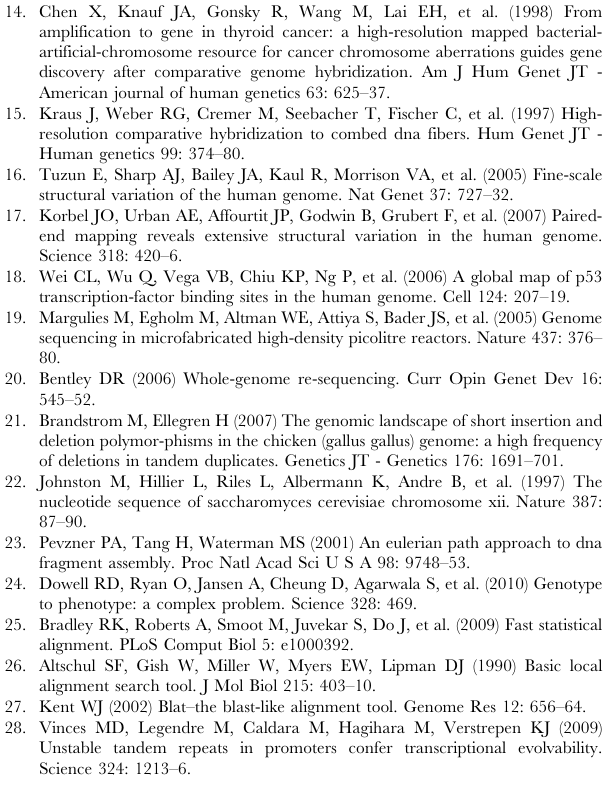
Figure S1 Plot of predicted log-intensity vs distance for intervals of size 1000, 2000, 4000, and 8000. The probability of termination at any base is.001 in all four intervals. Note the relatively linear shape over most of the interval followed by a more rapid decrease as the end effects become dominant. Figure S2 Ruler array data at a TY element insertion on chromosome XI in S 1278b. Note the blue line, which indicates the channel ratio. To the right of the insertion, marked by the black arrow, the ratio is close to one. To the left of the insertion, the S 1278b probe intensities are lower than the S288c intensities and the ratio increases accordingly. Figure S3 The four cases in which the Ruler Array analysis infers the presence of an indel from the segment fitting output. In (a), the segment fitting used one segment to fit the green channel but two segments to fit the red channel; consequently, the analysis makes a call at the split point in the red channel. In (b), the segment fitting used two segments in each channel. The green channel is greater to the right of the